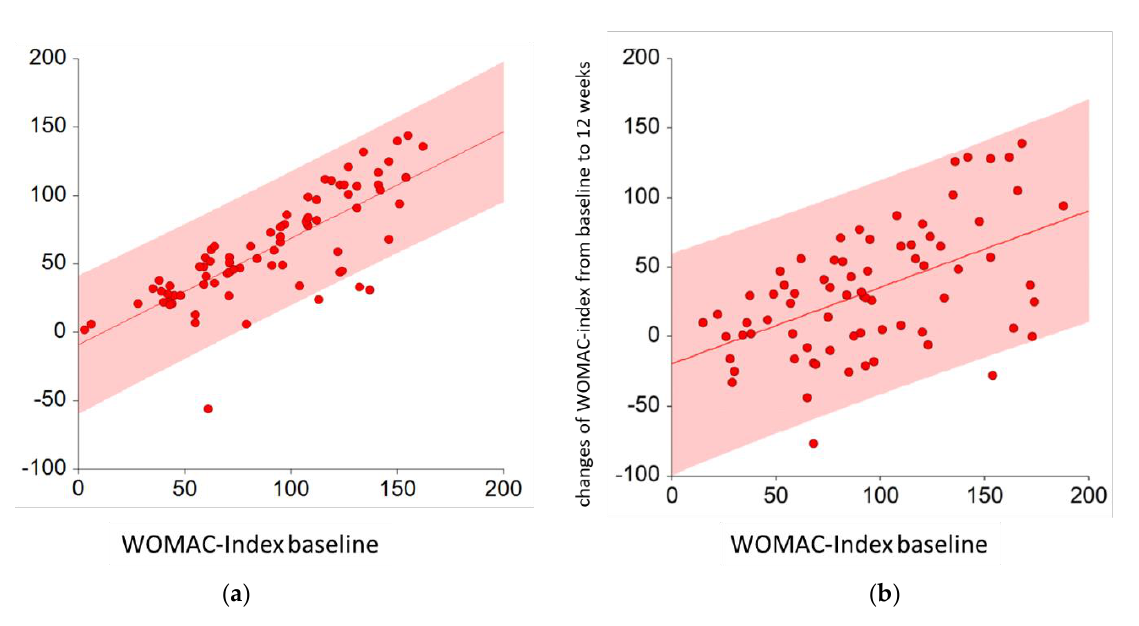
Figure 2. Estimated models for Ayurveda ( a ) and conventional therapy ( b ) with 95% CI for changes in the WOMAC Index from baseline to 12 weeks and WOMAC Index baseline.